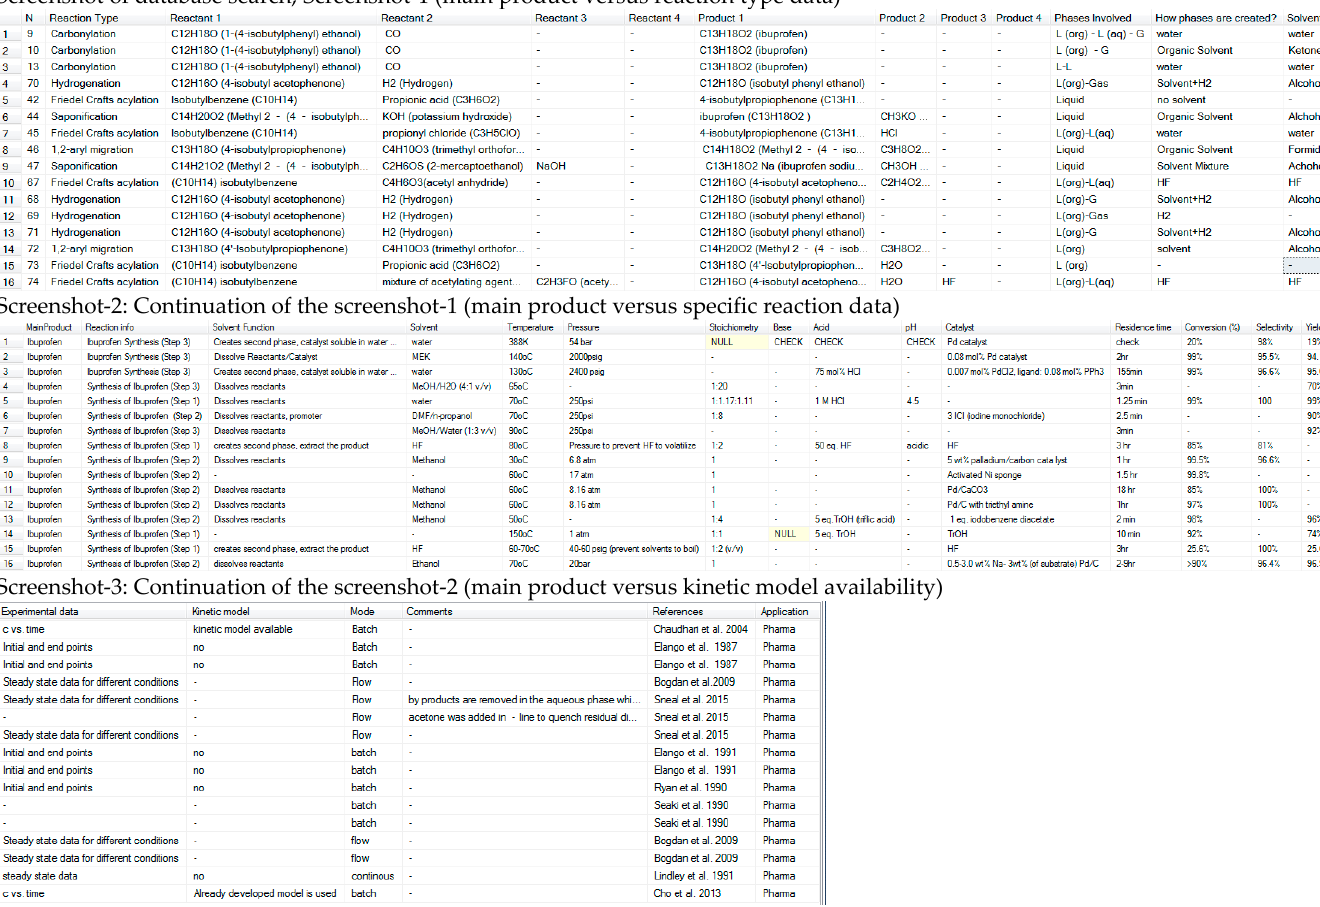
Screenshot of database search, Screenshot-1 (main product versus reaction type data)